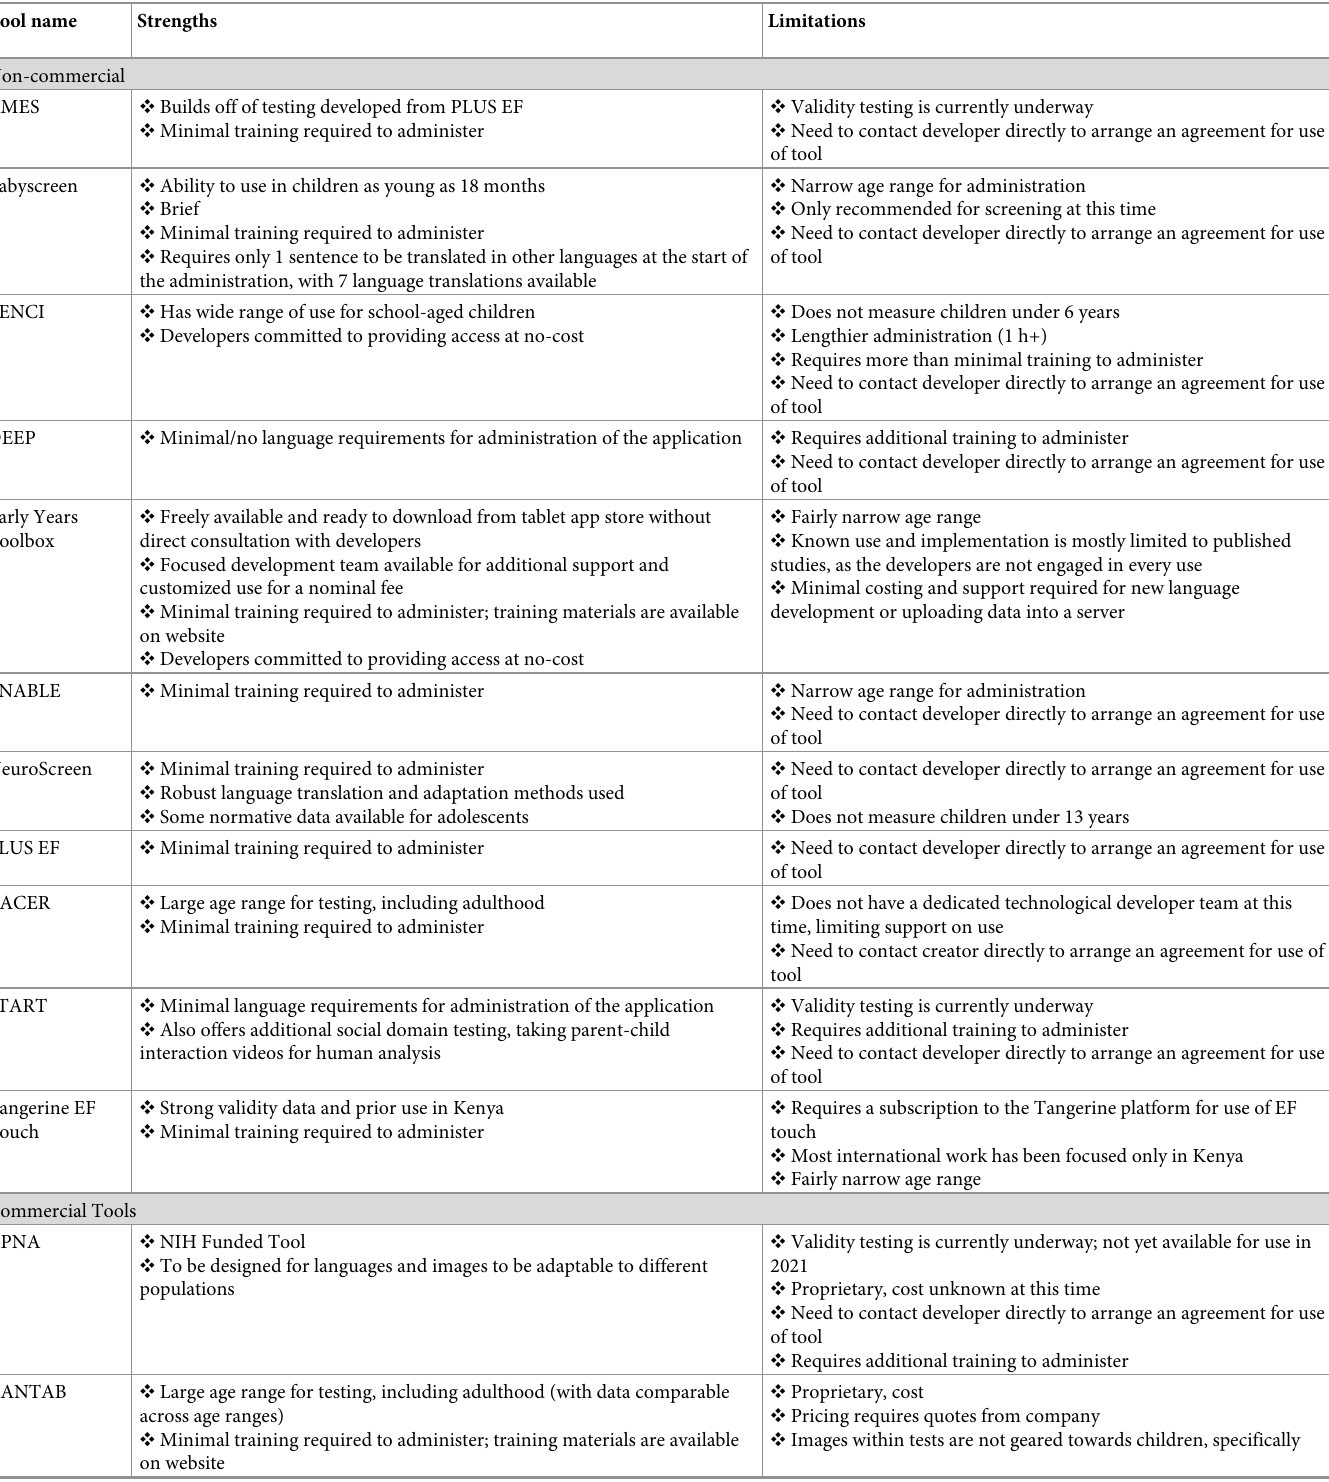
Table 3. General strengths and limitations of tablet-based cognitive